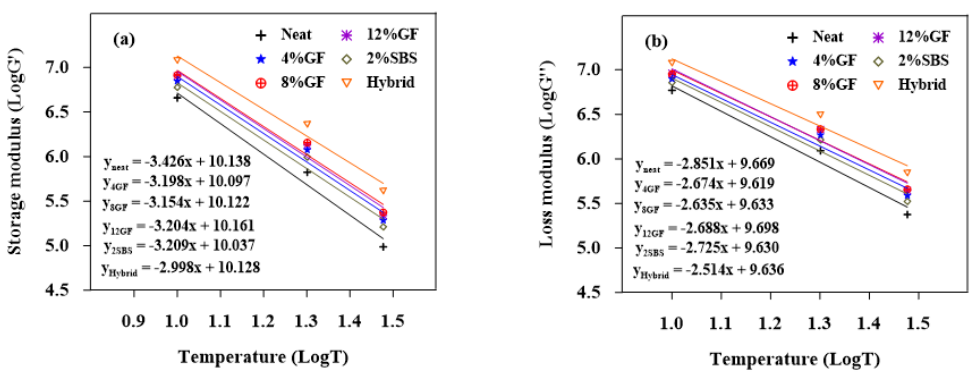
Figure 6. Sensitivity of RTFO binders to temperature for ( a ) G (cid:48) and ( b ) G (cid:48)(cid:48)